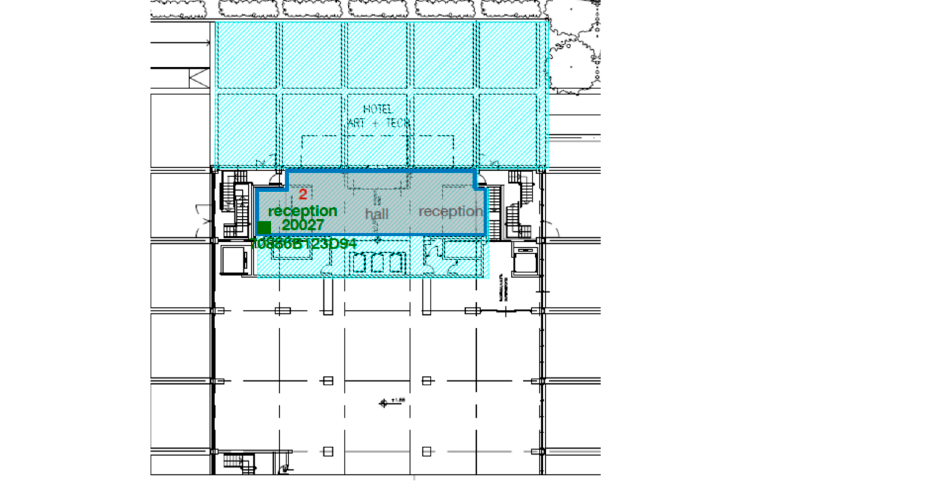
Figure 1. Floorplan of the hall area, with indication about the placing of the monitoring platform.